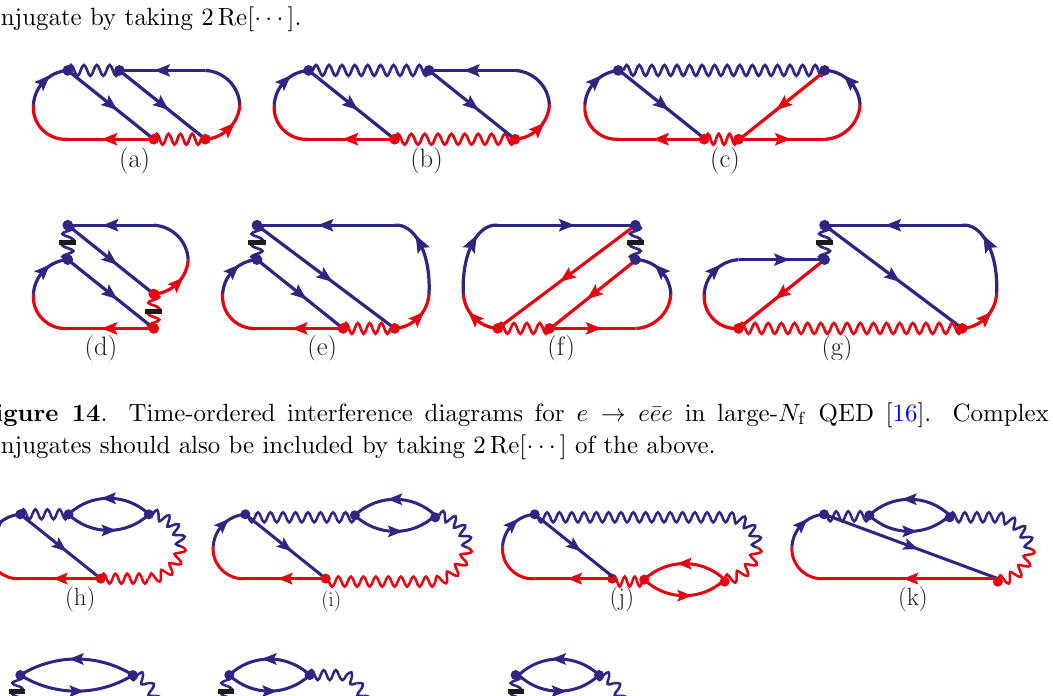
Figure 13 . Leading-order time-ordered diagram for e ! (cid:13)e . Blue represents a contribution to the amplitude and red represents a contribution to the conjugate amplitude. Repeated interactions